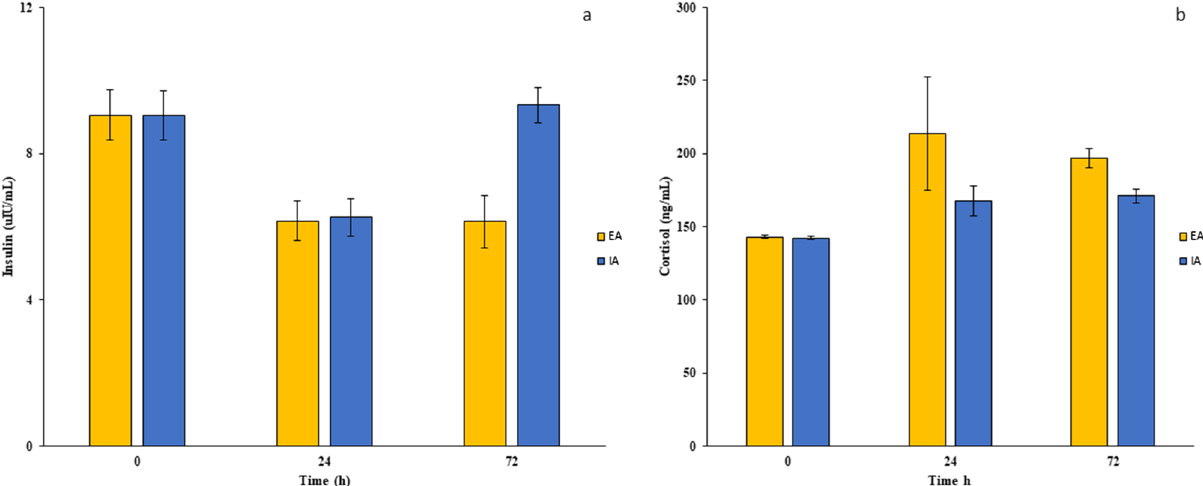
Figure 3. Hormone response after EA and IA surgeries in colon cancer patients. Serum insulin ( a ) and cortisol ( b ) levels were evaluated in colon cancer patients undergoing EA or IA anastomosis in laparoscopic right hemicolectomy surgeries at time 0 h and at 24 and 72 h postsurgery. Results are shown as means ± SD. Statistical analysis was performed using Kurskal Wallis test and Bonferroni post-test